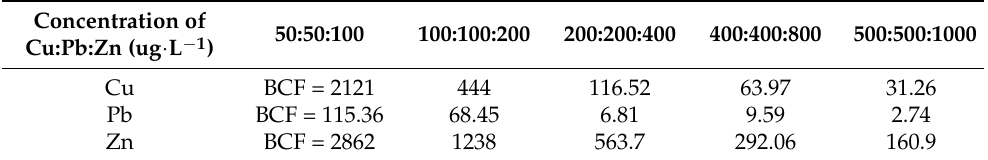
Table 1. Bio-enrichment coefficient of different heavy metals in Suaeda salsa under high-salinity